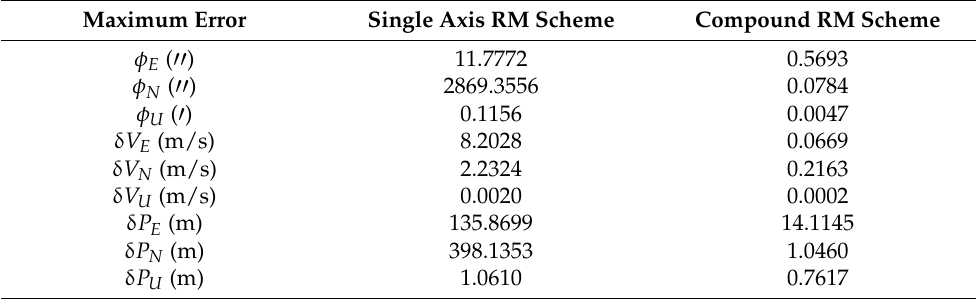
Table 3. Maximum errors between two rotational modulation schemes comparison.